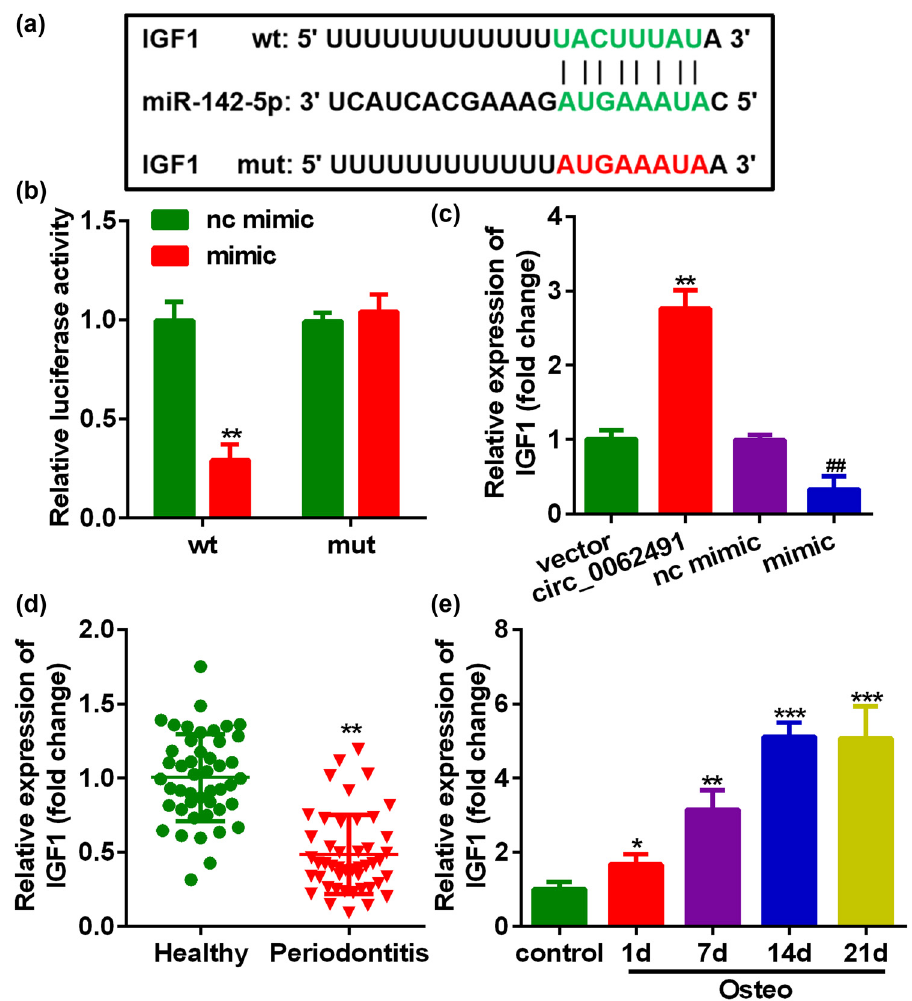
Figure 5: IGF1 was the target gene of miR - 142 - 5p. ( a ) Bioinformatics predicted the binding sites between miR - 142 - 5p and IGF1 . ( b ) Dual - periodontitis luciferase reporter assay was conducted to con fi rm the association between IGF1 and miR - 142 - 5p. ( c – e ) The expression of IGF1 was determined by qRT - PCR. * p < 0.05, ** p < 0.01, *** p < 0.001. vs nc mimic, vector, healthy and control group. ## p < 0.01, vs nc mimic